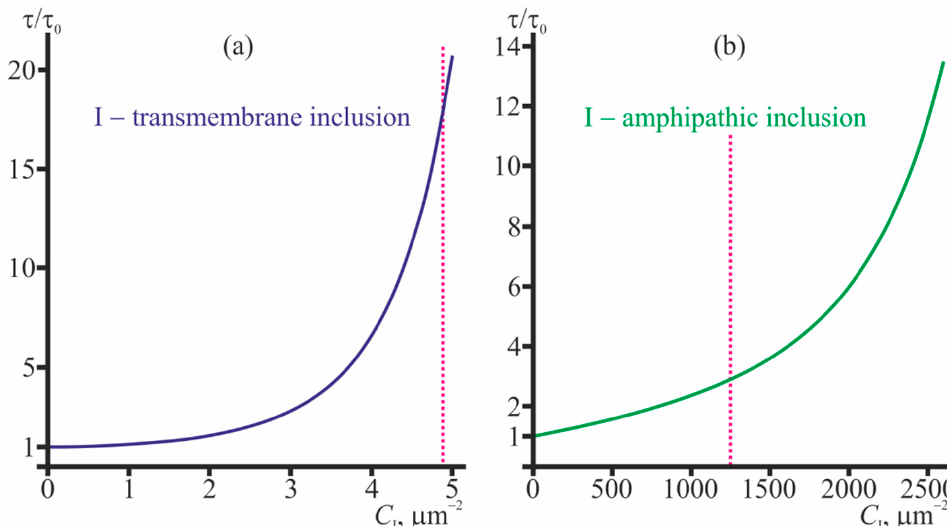
Figure 6. The dependence of the relative lifetime, τ / τ 0 , of the solitary conducting dimer on ( a )—concentration of transmembrane inclusions; ( b )—concentration of amphipathic membrane inclusions (incorporated into the top monolayer). The dependencies were obtained based on Equation (31). The magenta dotted lines bound the range of concentrations where the correction to the main approximation calculated within the perturbation theory reaches 20%; for larger C I concentrations the application of the perturbation theory is not strictly valid.